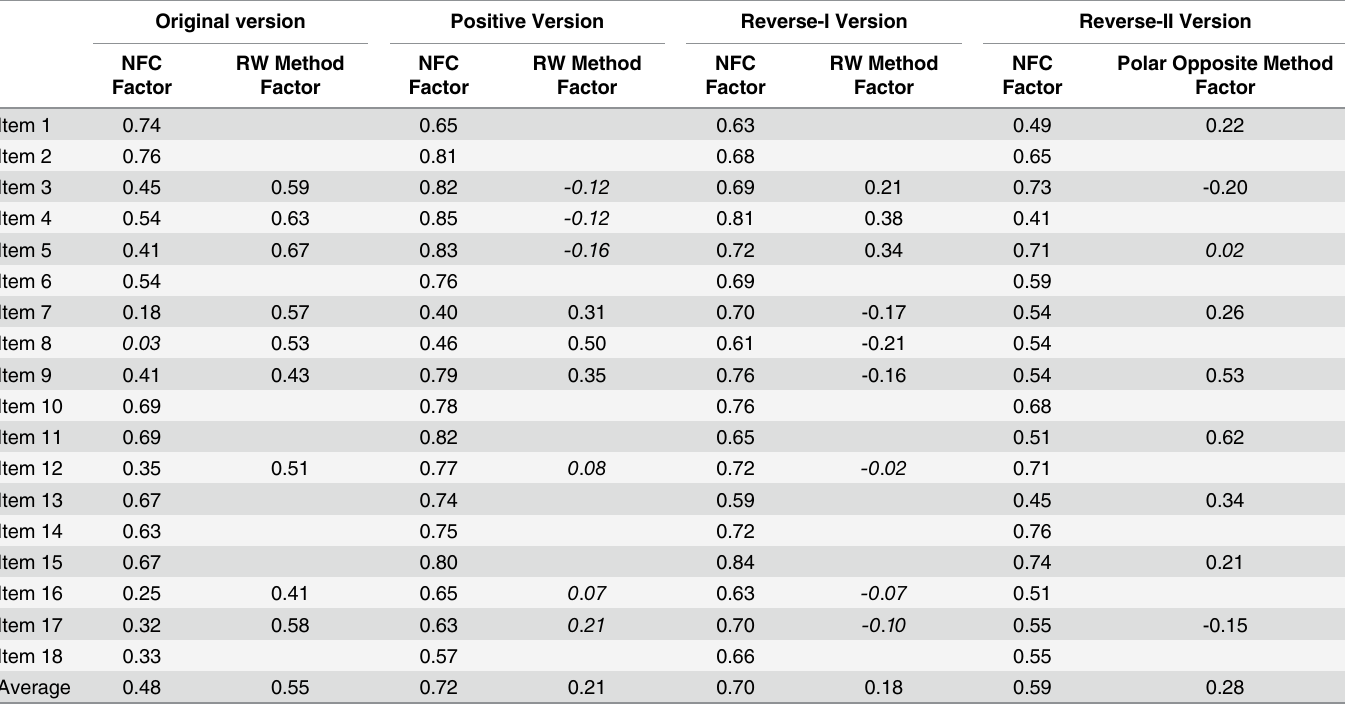
Table 6. Standardized Factor Loadings of Model 3 for the Four Scale